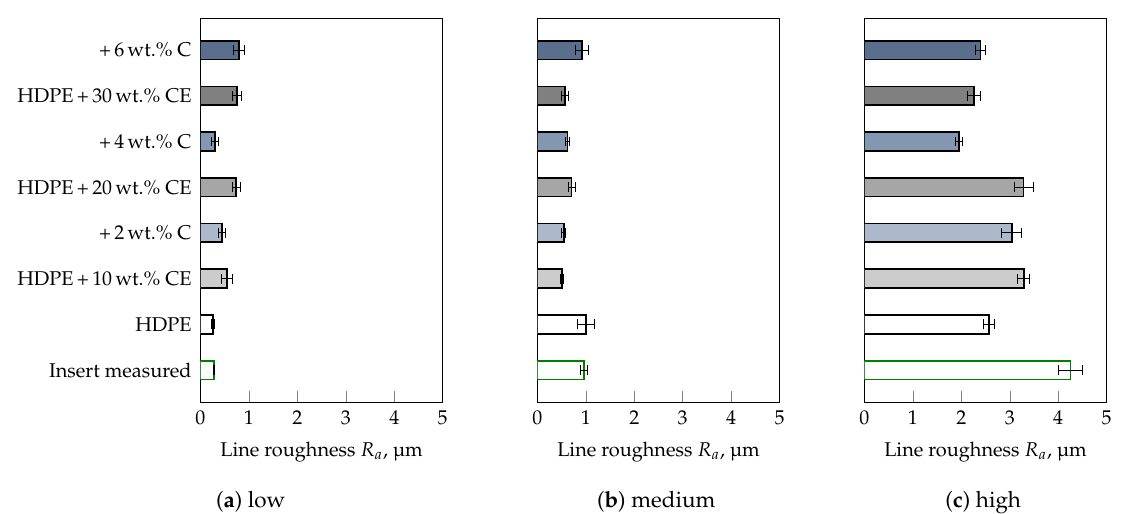
Figure 6. Influence of filler CalPlex Extra (CE, D 50 = 0.7–0.90 µ m), and compatibilizer (C) content on the impression quality. Deployed insert with a target line roughness of ( a ) 0.2 µ m (low), ( b ) 0.8 µ m (medium), and ( c ) 3.2 µ m (high).